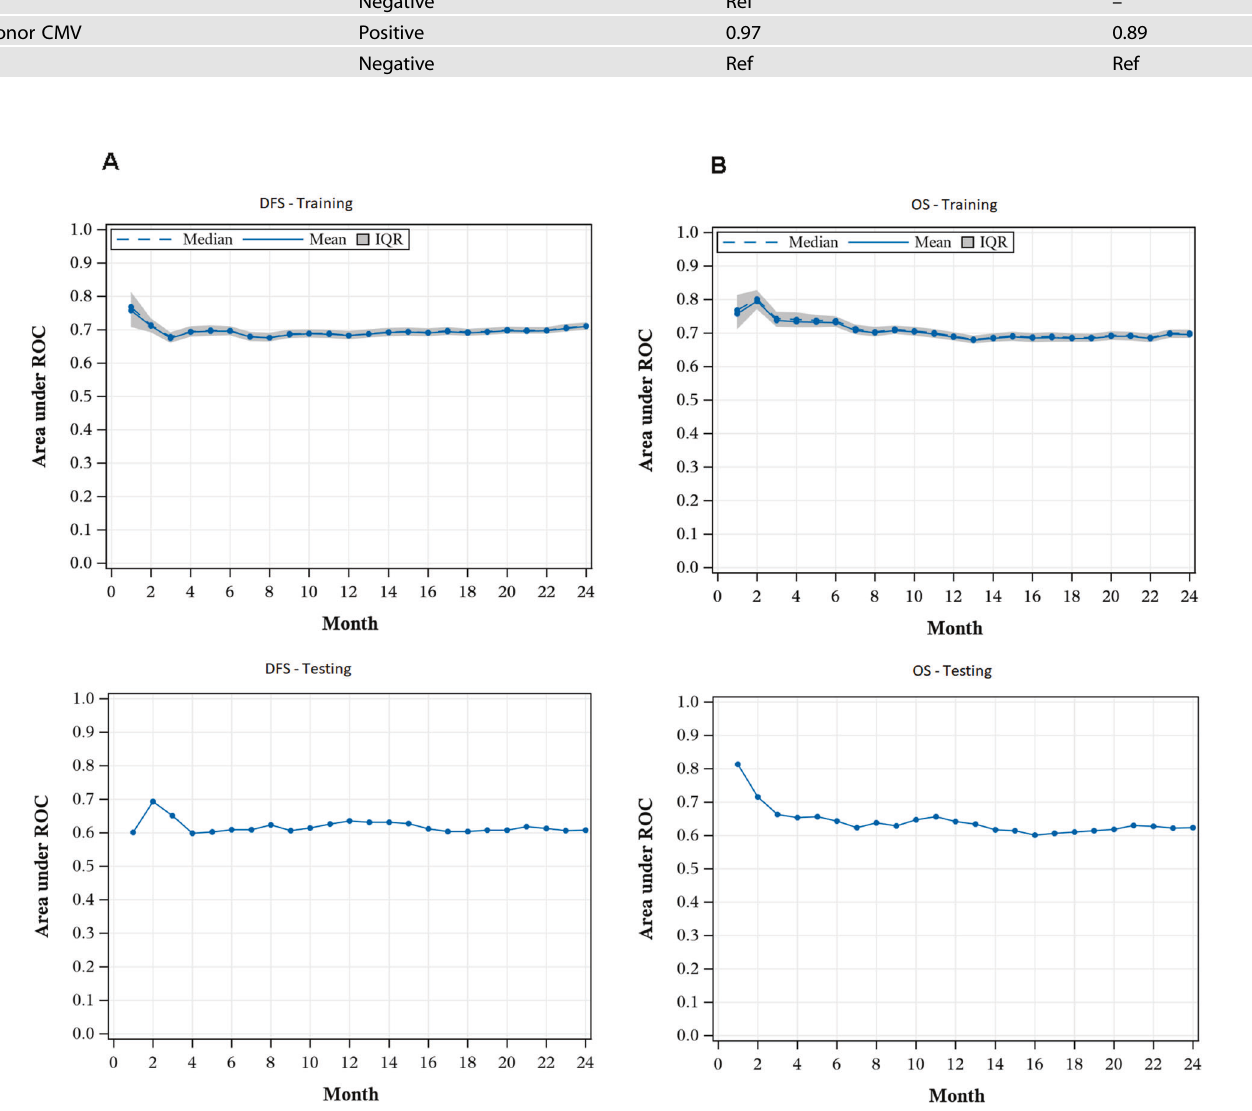
Fig. 2 Time-dependent AUC for disease-free and overall survival. A Panels show time-dependent AUC values for disease-free survival in the training and testing cohorts, at 0.71 and 0.61, respectively. B Panels show time-dependent AUC values for overall survival in the training and testing cohorts, at 0.70 and 0.61,